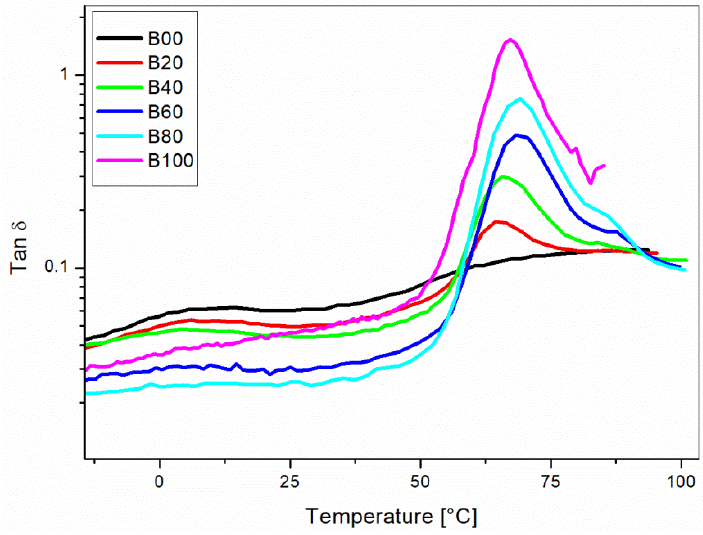
Figure 5. Tan δ versus temperature curves for unreinforced blends of PP/Liquid Wood as a function of the Liquid Wood (LV) content.